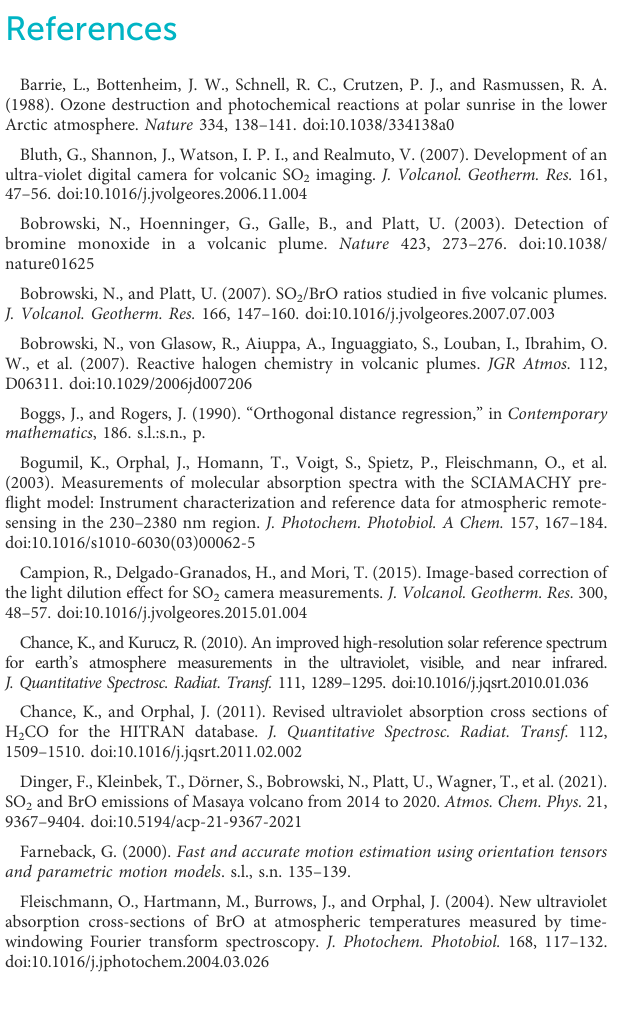
SUPPLEMENTARY FIGURE S4 Integrated transect of the SO 2 CD (SO 2 CD multiplied with the plume cross section σ plume ) for the time period of the SO 2 fl ux measurement in Figure 6A. The orange points denote the measurements during the DOAS car